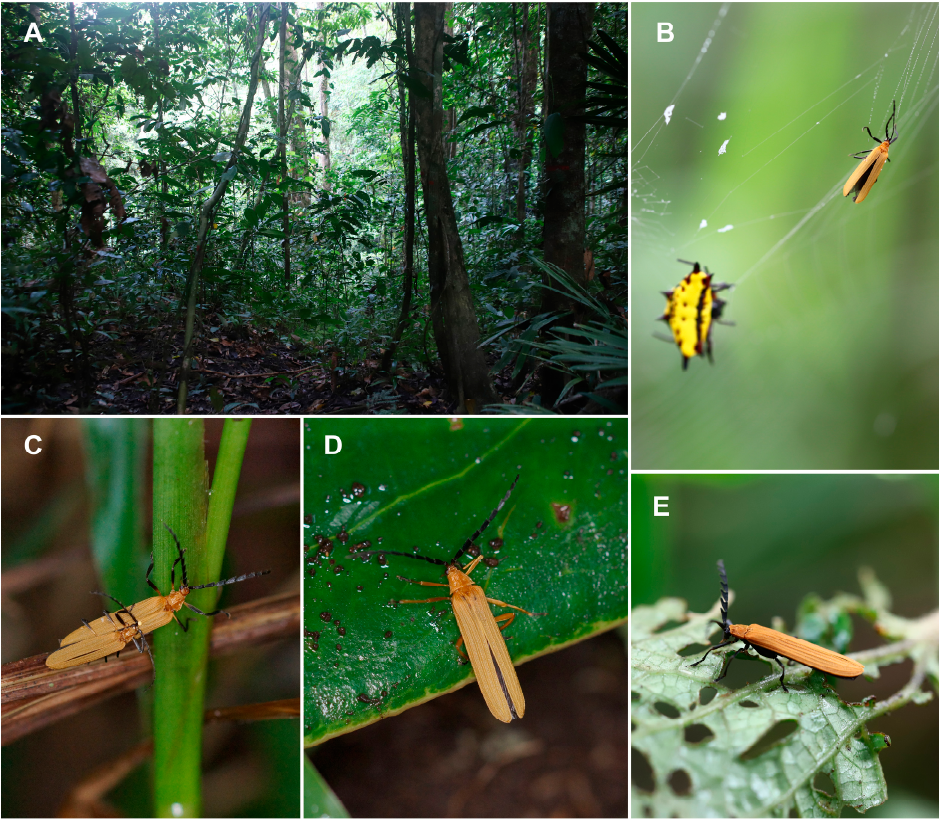
Figure 1. ( A ) Lowland rain forest in New Guinea; ( B ) Eniclases sp. in the web of Gasteracantha sp. in New Guinea. ( C ) Eniclases sp. ( D ) Microtrichalus sp. ( E ) Porrostoma sp. (Photographs © Authors).